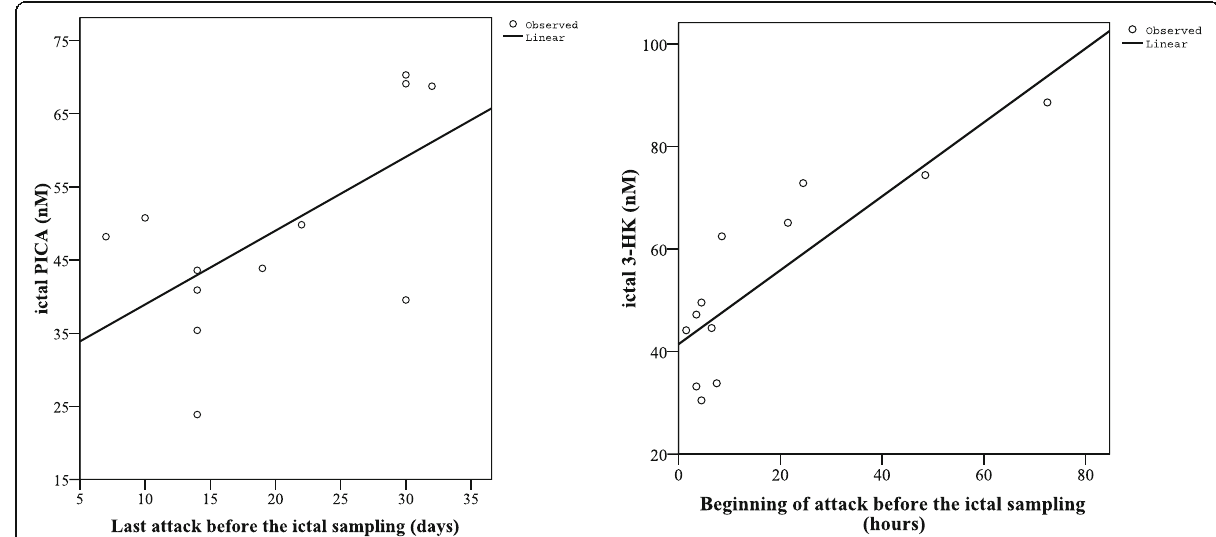
Fig. 5 Associations between altered concentrations of PICA and 3-HK and ictal characteristics of all migraine patients (n = 12). PICA: Picolinic acid, 3-HK: